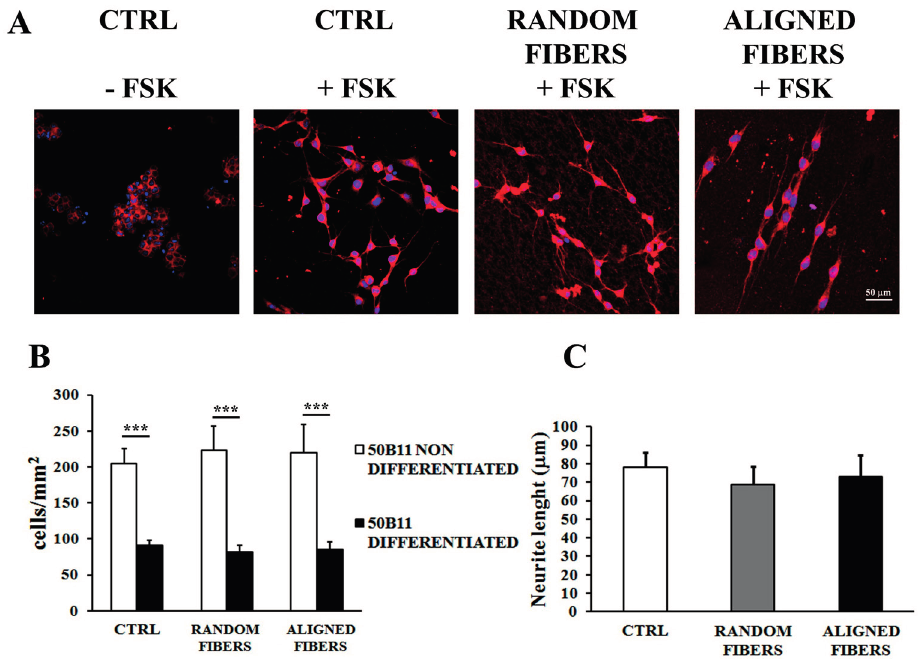
Figure 5. 50B11 differentiation: Confocal images (40× magnification) after DAPI (blue) and β -tubulin (red) staining of B5011 seeded on poly- L -lysine coated coverslips (control condition), random fibers and aligned fibers 24 h after forskolin treatment. Scale bar: 50 μ m. ( A ) 50B11 cell number is expressed as cells/mm 2 ± standard error of the mean (SEM) ( B ); Neurite length is expressed in μ m ( C ); Asterisks refer to significant statistical difference with *** p ≤